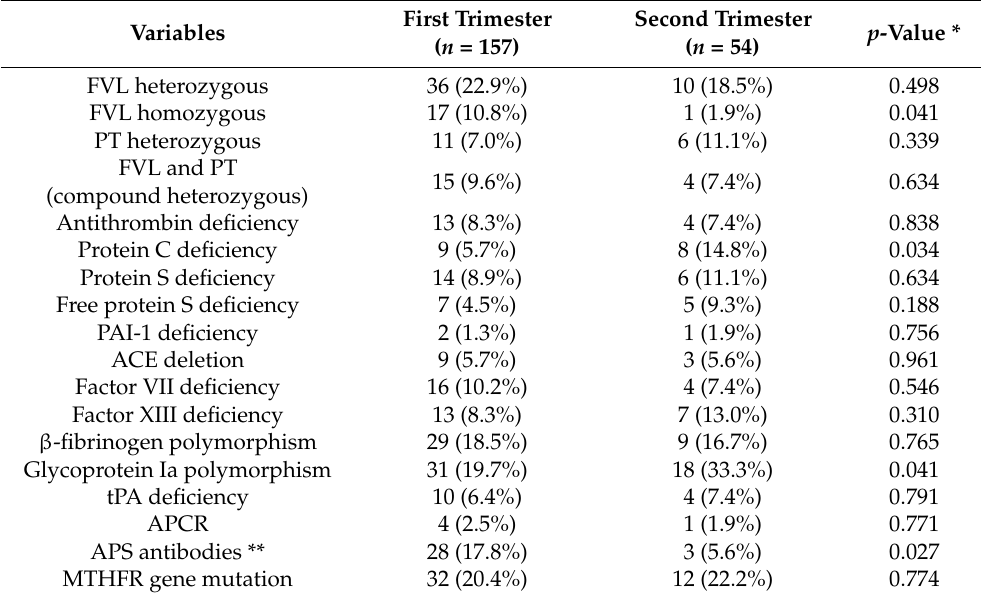
Table 3. Comparison of laboratory analysis between women with a history of first trimester and second trimester pregnancy